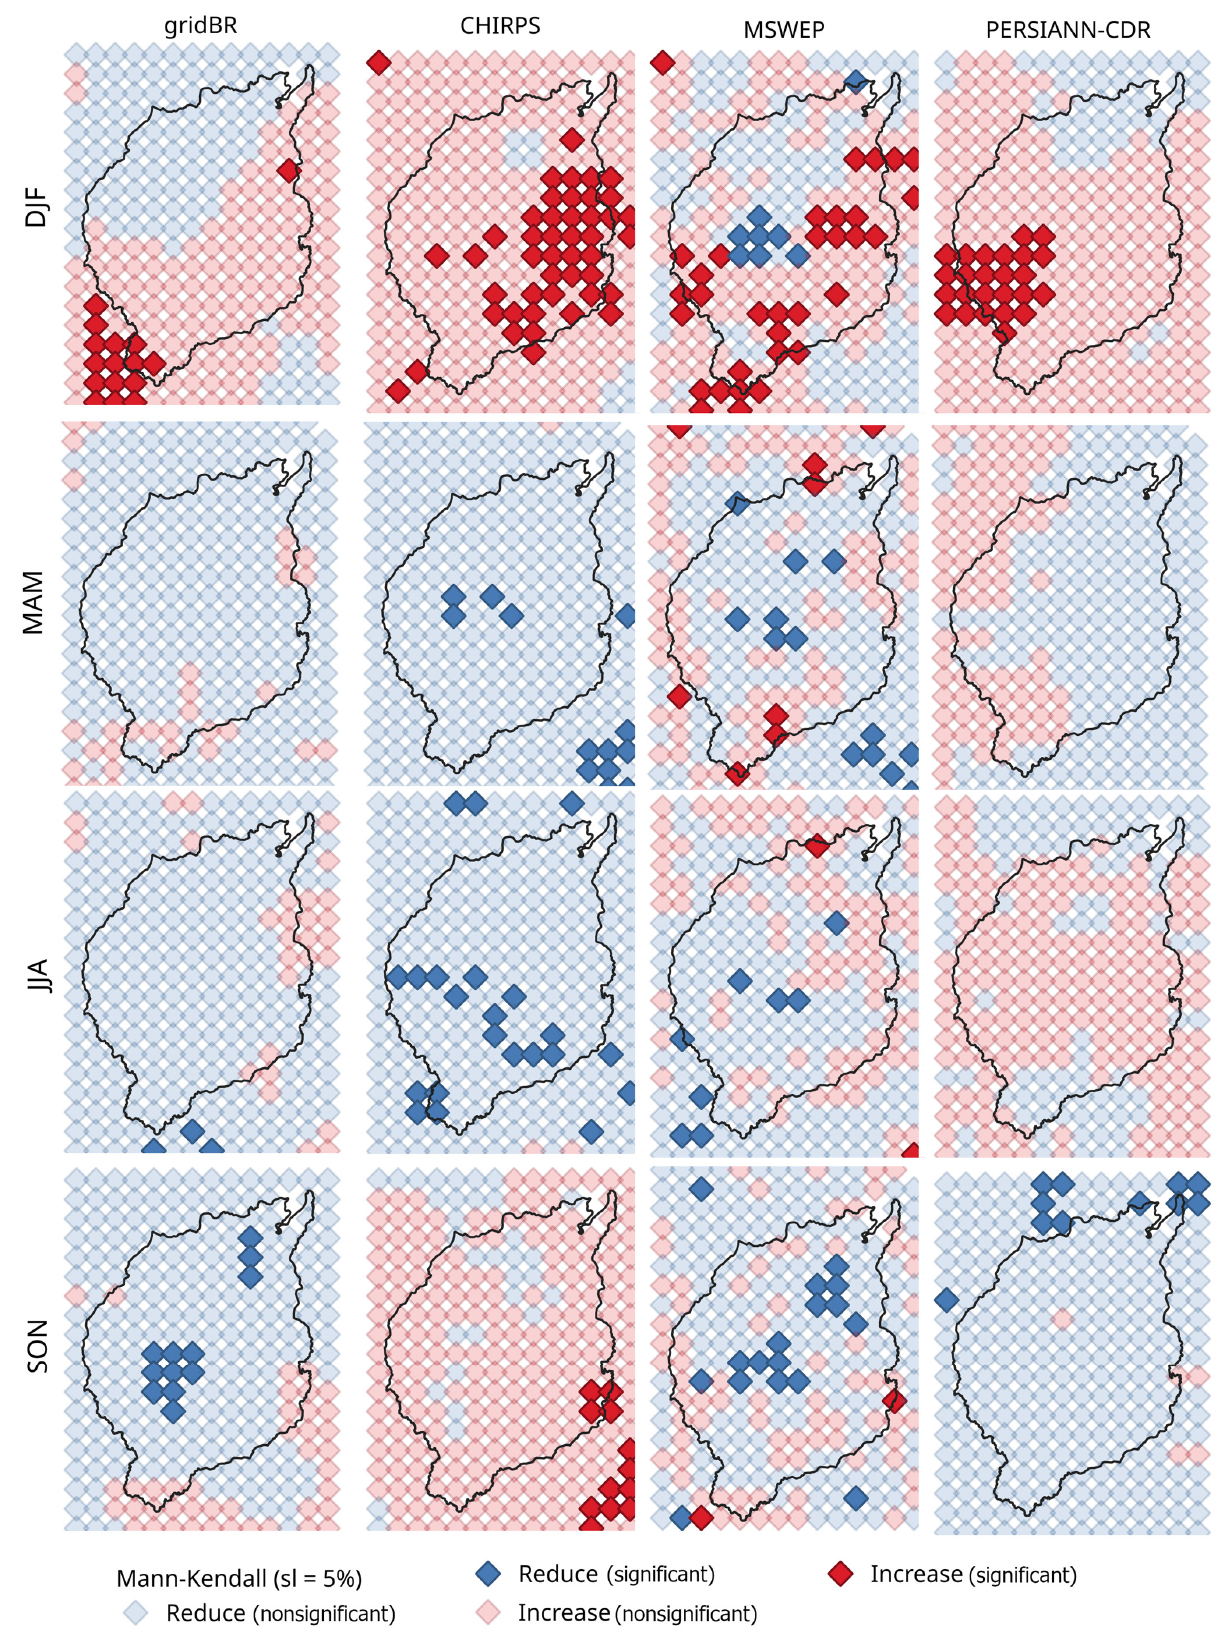
Figure 10. Mann–Kendall decreasing and increasing trends (5% level of statistical significance) as a function of the seasonal mean daily rainfall in the MDB (gridBR × RES) from 1983 to 2013.